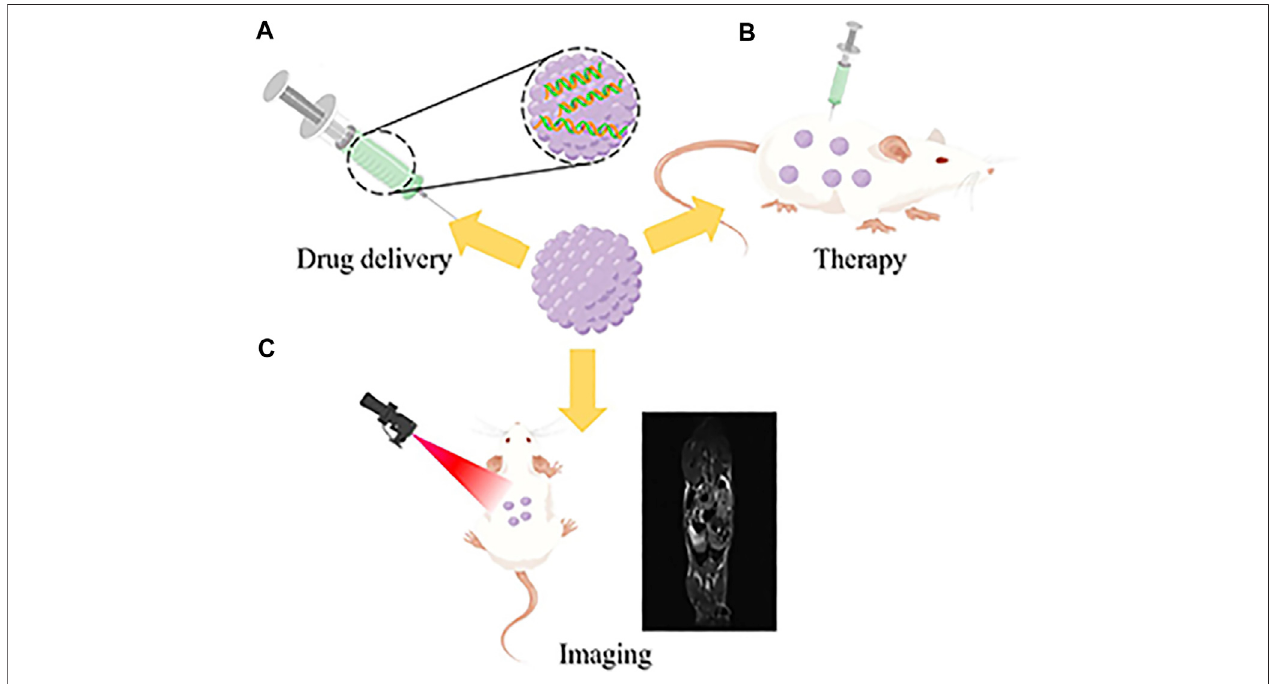
FIGURE 5 | Clinical application of NPs.